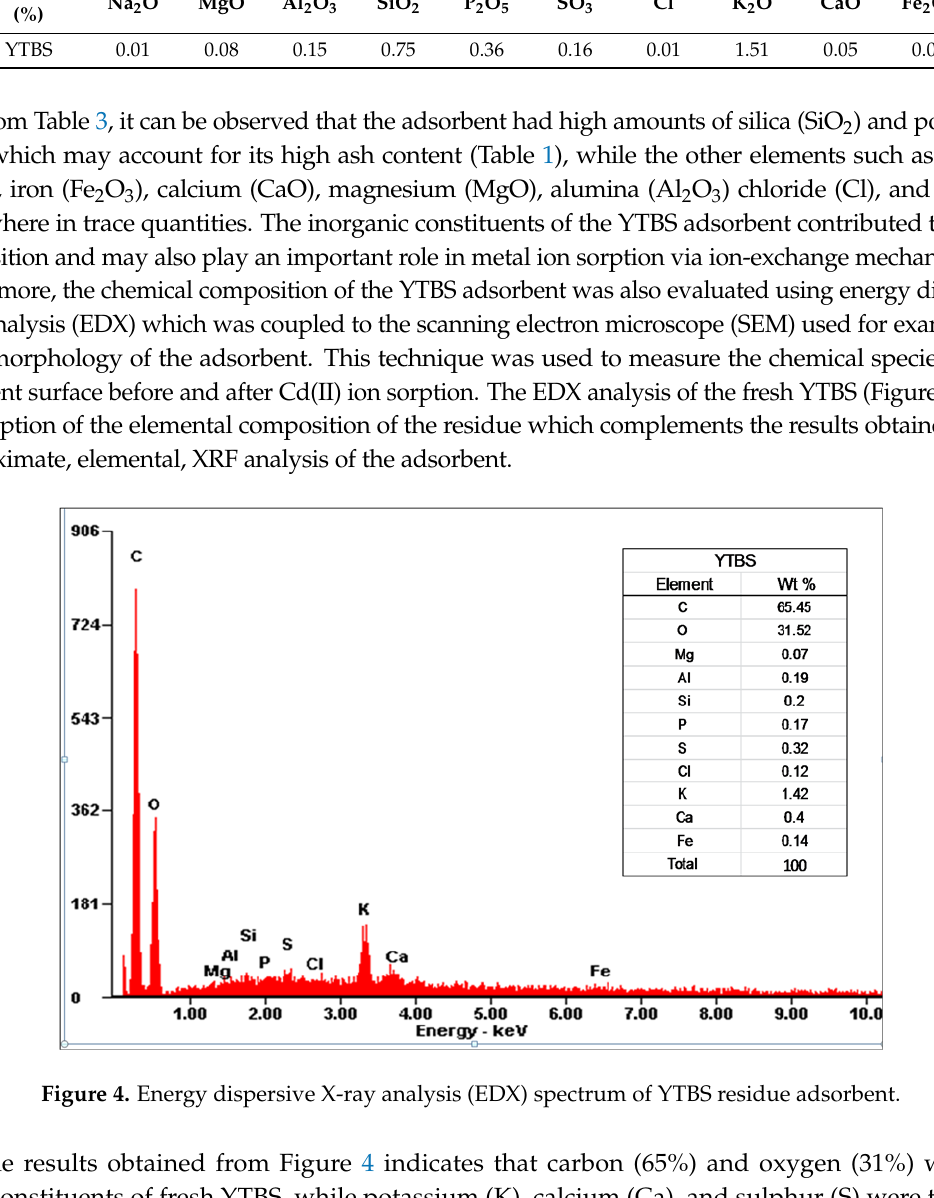
Table 3. X-ray fluorescence spectrometry (XRF) of YTBS residue adsorbent.